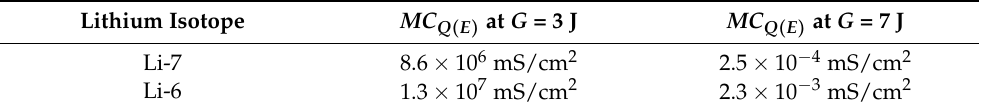
Table 11. The table shows that extracellular lithium isotopes can have a range of quantum membrane conductance from the value at G = 3 J to the value at G = 7 J according to the setting values in graph (a) of Figure 6.